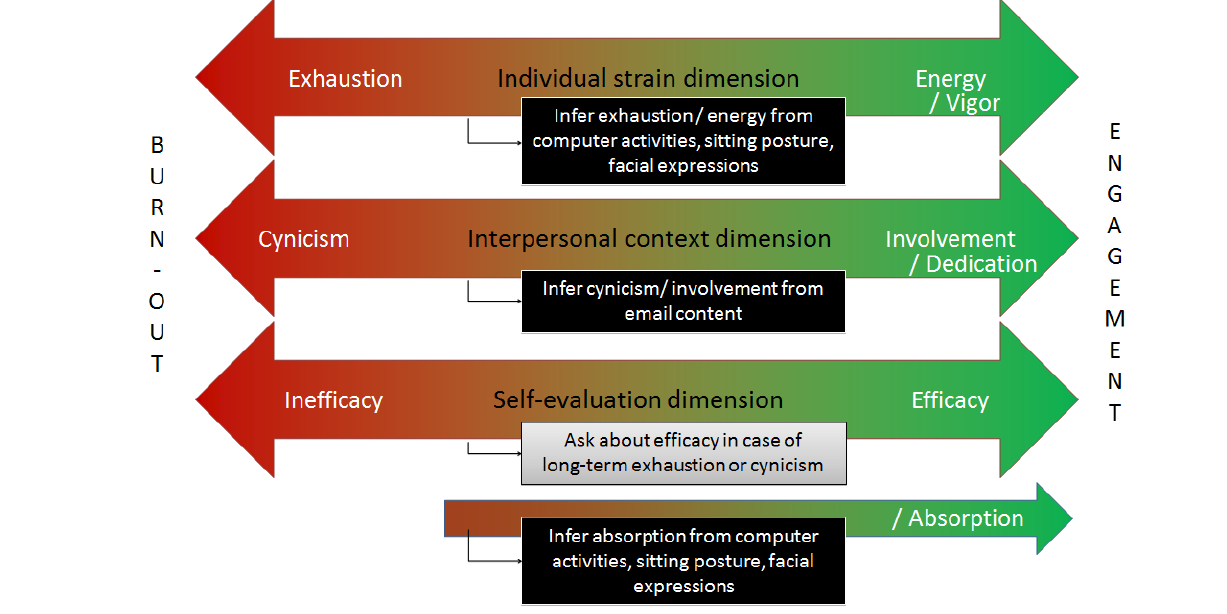
Figure 3. Well-being at work concepts "burn-out" and "engagement" and ideas to infer certain aspects from captured (sensor)